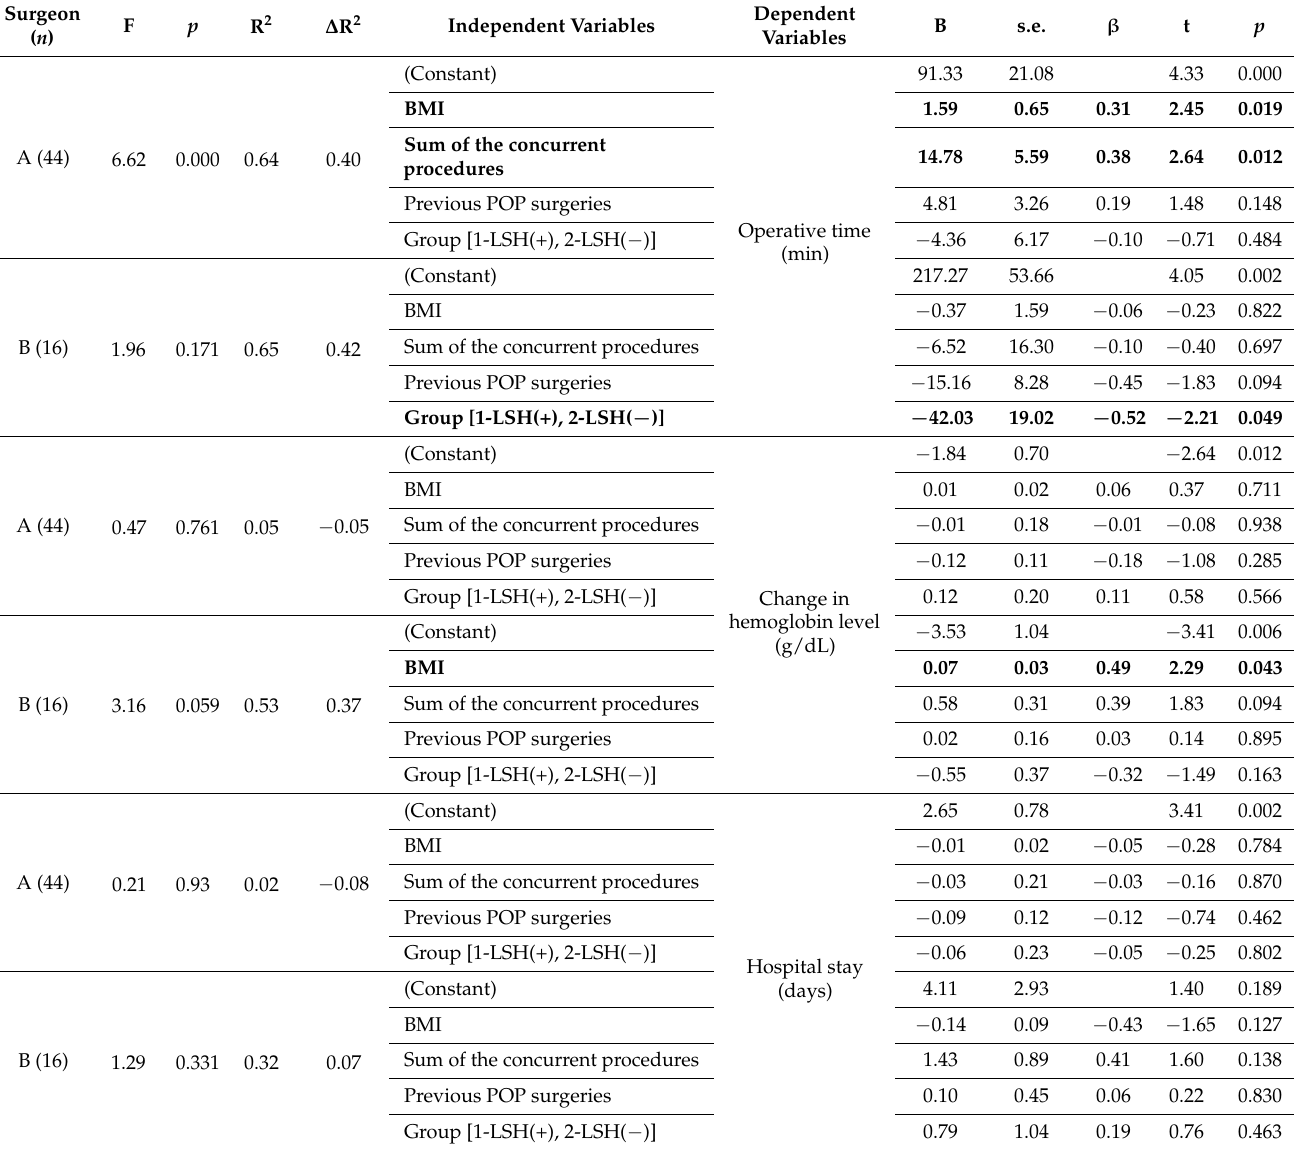
Table 3. Regression models for operative time, change in hemoglobin level and hospital